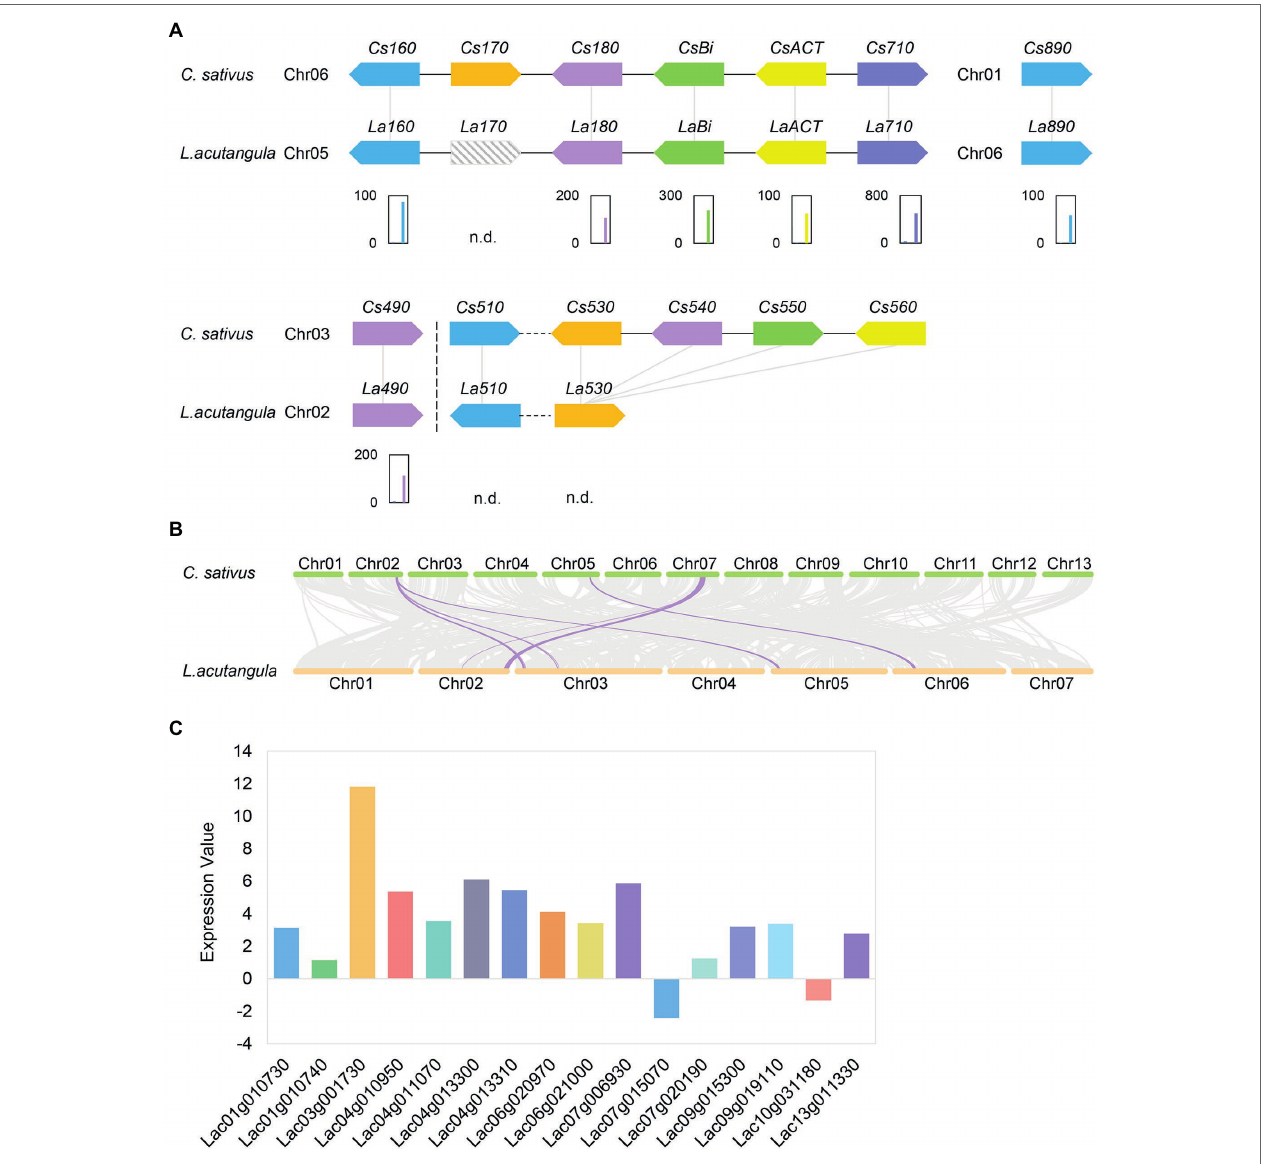
FIGURE 4 | Cucurbitacin biosynthesis genes. (A) The distribution and expression of cucurbitacin biosynthesis genes are shown by the fragments per kilobase of transcript per million (FPKM) values. Left bar, S1174 and Right bar, WM709. n.d., not detected. (B) Synteny blocks between cucumber and Luffa . (C) Expression analysis of UGT s between WM709 and S1174 Luffa varieties. The height of the columns represents the log2 [fold change